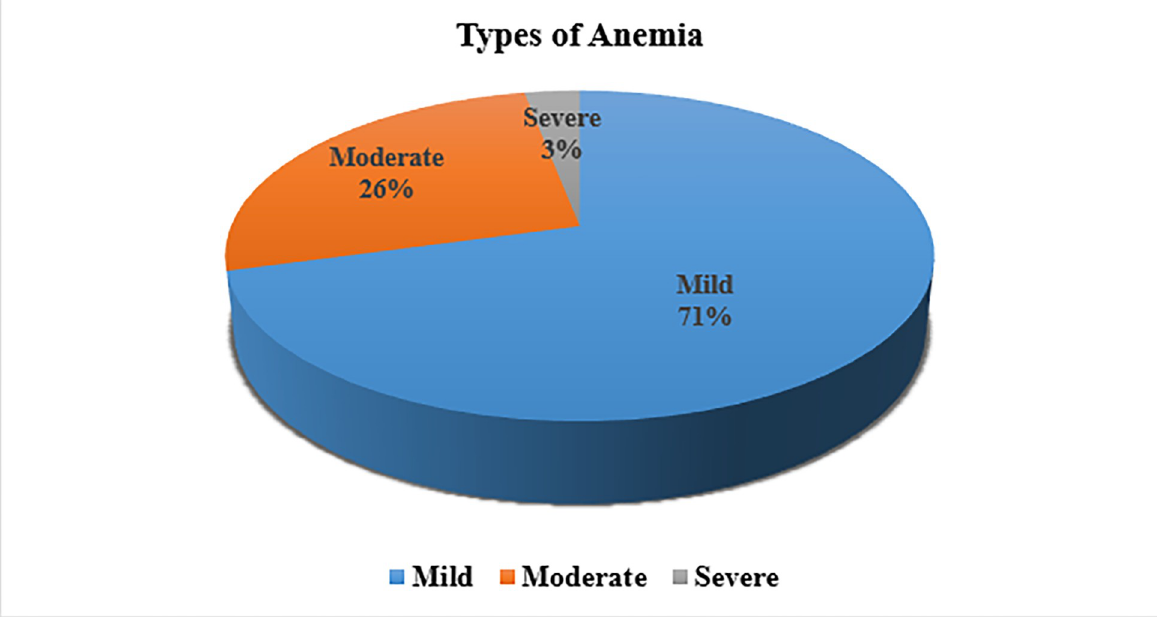
Fig 2. Distribution and severity of anemia among pregnant women attending antenatal care at Debre Markos Referral Hospital, Northwest Ethiopia, 2016.